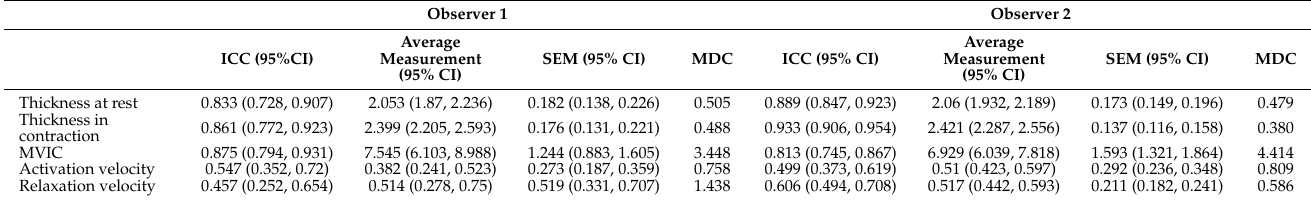
Table 2. Intra-observer